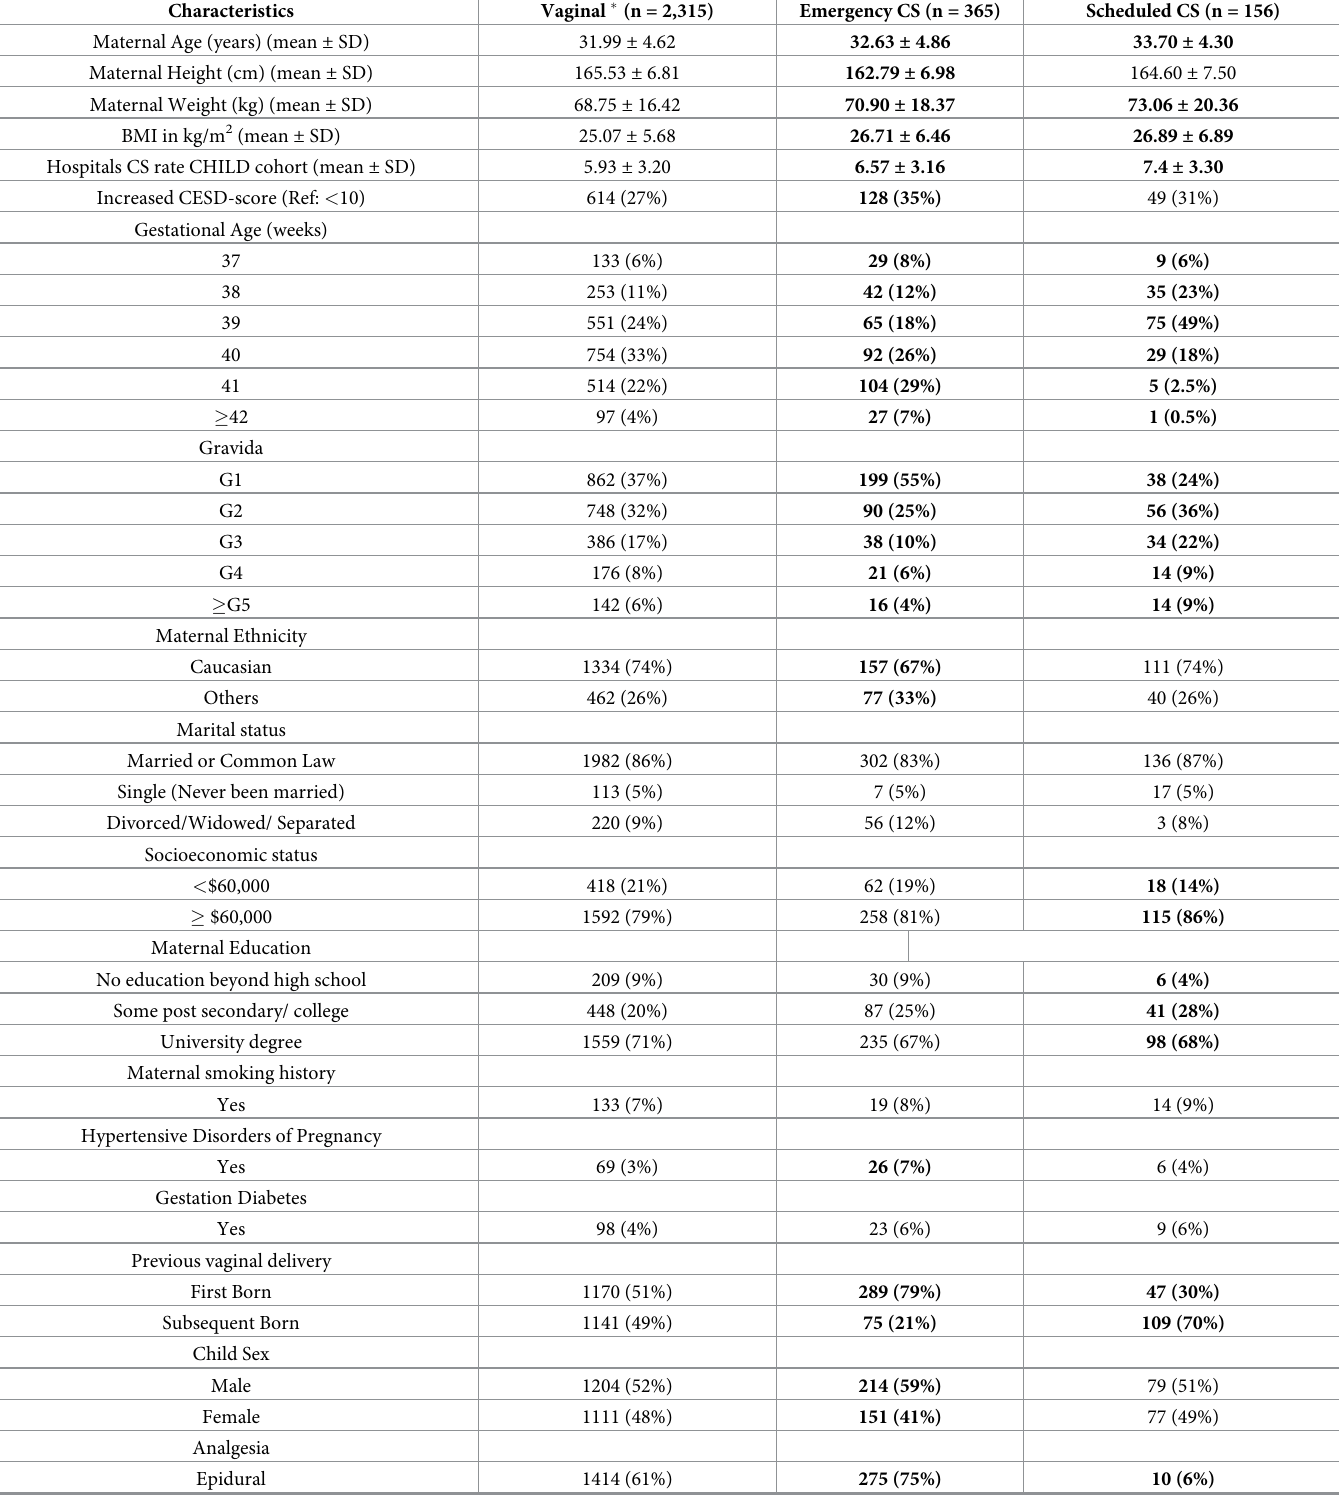
Table 1. Demographic, antenatal and obstetric characteristics associated with mode of